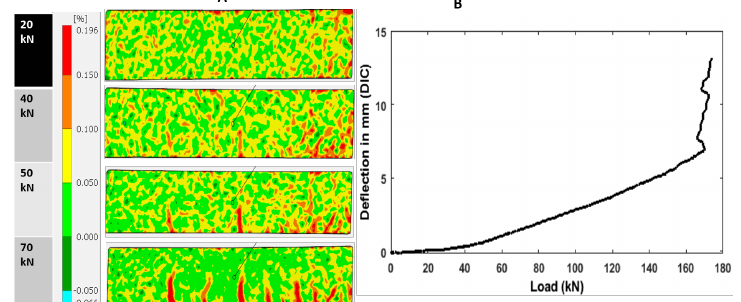
Figure 19. Crack propagation along with strain map ( A ) and Deflection ( B ) at different load levels of specimen (1st stages).